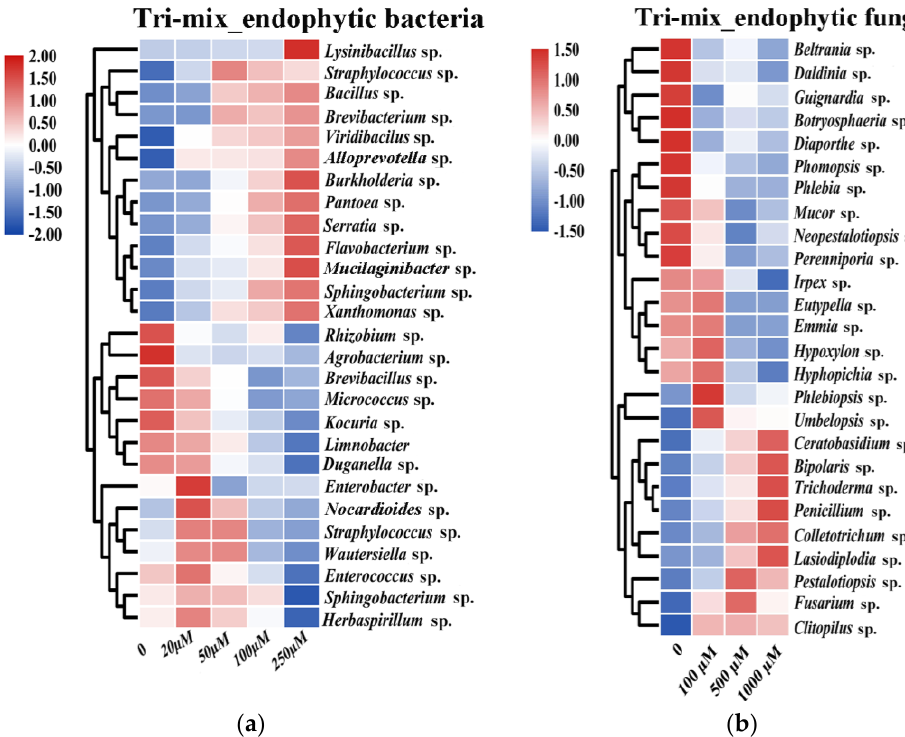
Figure 2. Effects of Triterpenoids on the growth of bacterial and fungal isolates. Heatmap showing log2 fold change in ( a ) cell density (OD 600 ) of bacterial strain and ( b ) weight (g) of fungal strain treated with mix (S1–4) by gradient concentration at 48 hours (bacteria) and 12 days (fungi). Log2 fold change is an estimate of the log2 ratio of relative value to that initial value. A value of 1.0 indicates two-fold greater expression in heatmap cluster. Five biological replicates per treatment were used for analysis.